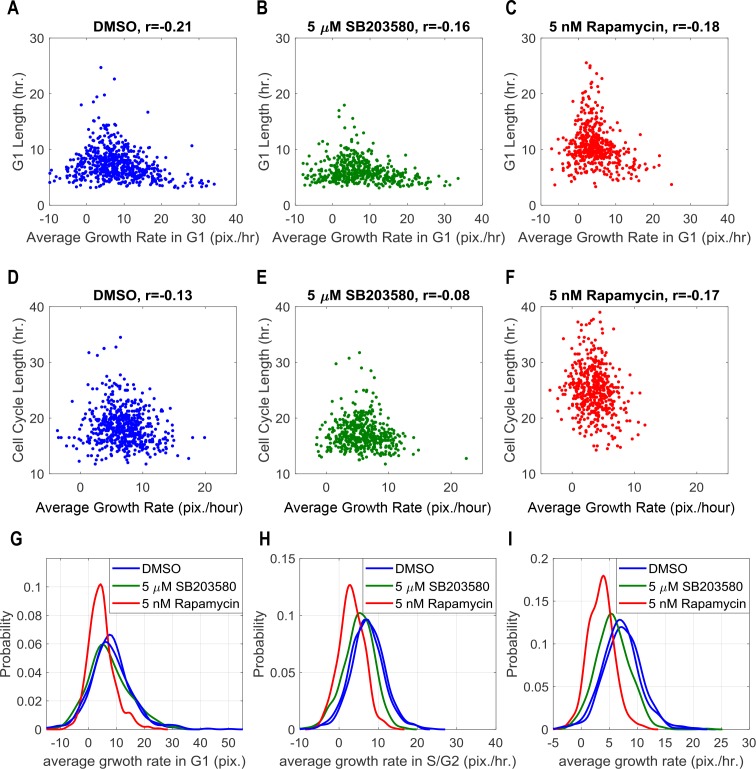
Cellular growth rate also negatively correlates with G1 or cell cycle duration.(A–C) Scatterplots displaying relationship between average growth rate in G1 stage with G1 duration for individual cells in DMSO control, p38 inhibition and mTOR inhibition. (D–F) Scatterplots displaying relationship between average growth rate over cell cycle with cell cycle duration for individual cells in the three conditions. r indicates Spearman’s correlation coefficient. (G–I) Distribution of average growth rate in G1 (before Geminin rise), S/G2 (after Geminin rise) and over the entire cell cycle for the three tested conditions. While mTORC1 inhibition by Rapamycin decreases growth rate, p38 inhibition by SB203580 does not significantly affect growth rate in G1. The meta data and source code used in this analysis is presented in Figure 3—source data 2.